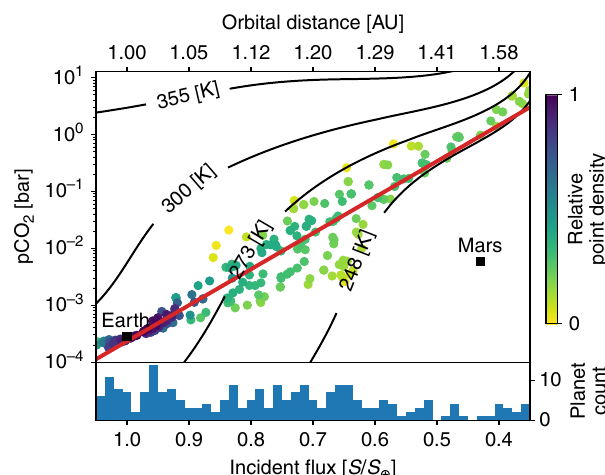
Fig. 6 The expected distribution of stable, steady-state pCO 2 on Earth- like planets if Q , f land , and f bio are fi xed to 1, i.e., modern Earth values. Except for fi xing Q = f land = f bio = 1, this fi gure is generated identically to Fig. 1. The spread in pCO 2 in the outer HZ is due to the temperature- and pCO 2 -dependence of continental weathering ( T e and α ). This is expected from Eq. (4), which shows that T e and α will be increasingly in fl uential as pCO 2 and surface temperature deviate from the modern Earth values, as discussed in the Results, subsection “ Habitable zone climate theory revisited ” . Without changes in Q , f land , and f bio , there is little spread in pCO 2 in the inner